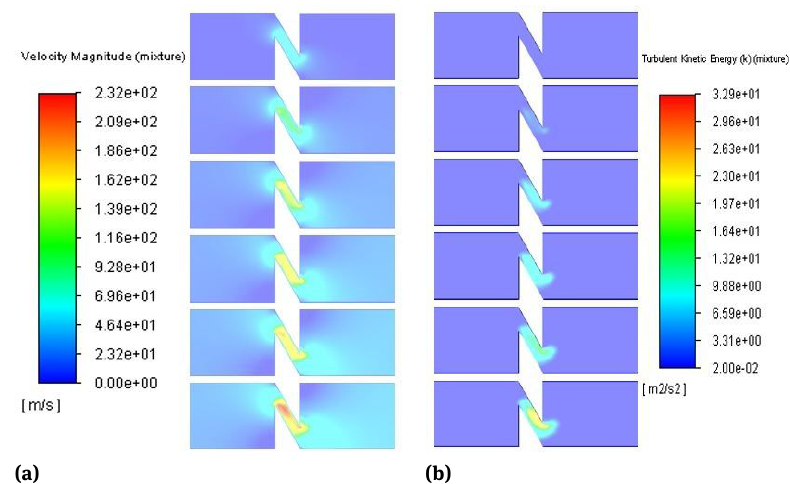
Figure 10: (a) – Change in velocity magnitude at inlet pressures from 1–6 bars. (b) – Turbulent kinetic energy change was illustrated at pressures 1–6 bars in ball